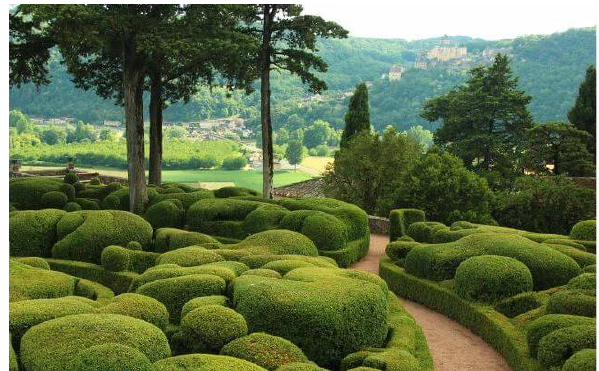
Figure 9. Eden garden projects (Cornwall, Great Britain) Figure 10. Les Jardins de Marqueyssac (Dordogne,